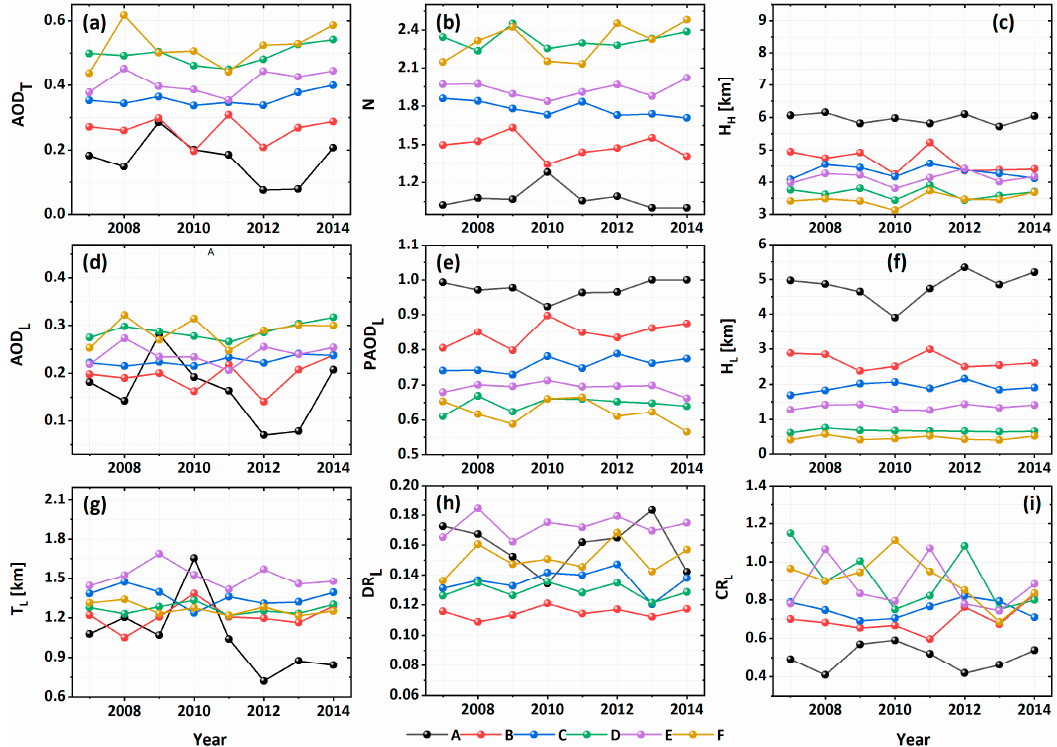
Figure 2. Interannual variations in the optical characteristics of aerosol layers over Pakistan (A: Gilgit-Baltistan, B: Jammu-Kashmir, C: Khyber-Pakhtunkhwa, D: Punjab, E: Balochistan, F: Sindh) during daytime from 2007 to 2014. ( a ) the AOD of all the aerosol layers (AOD T ), ( b ) the AOD of the lowest aerosol layer (AOD L ), ( c ) the top altitude of the lowest aerosol layer (H L ), ( d ) the top altitude of the highest aerosol layer (H H ), ( e ) the number of aerosol feature layers (N), ( f ) the thickness of the lowest aerosol layer (T L ), ( g ) the AOD proportion of the lowest aerosol layer (PAOD L ), ( h ) the volume depolarization ratio of the lowest aerosol layer (DR L ), and ( i ) the color ratio of the lowest aerosol layer (CR L ).